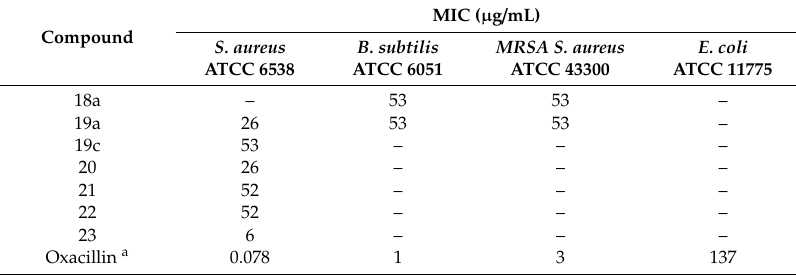
Table 13. Minimum inhibitory concentrations (MICs) for selected compounds isolated from Bletilla striata from Jiang et al. (2019) [74].